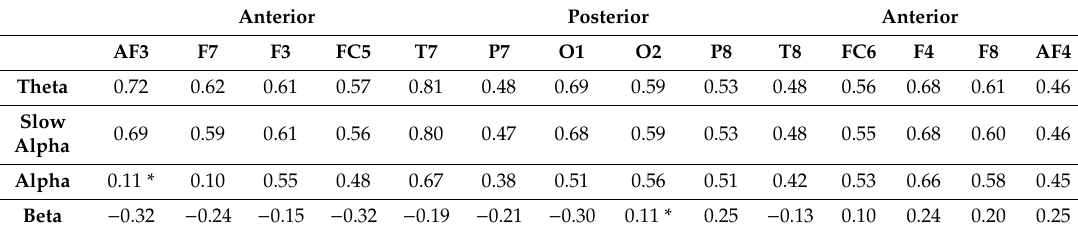
Table A1. Correlation between EEG PSD frequency bands and ground truth after triggered by image contents where the significant correlation ( p value ≤ 0.05) is indicated with *.